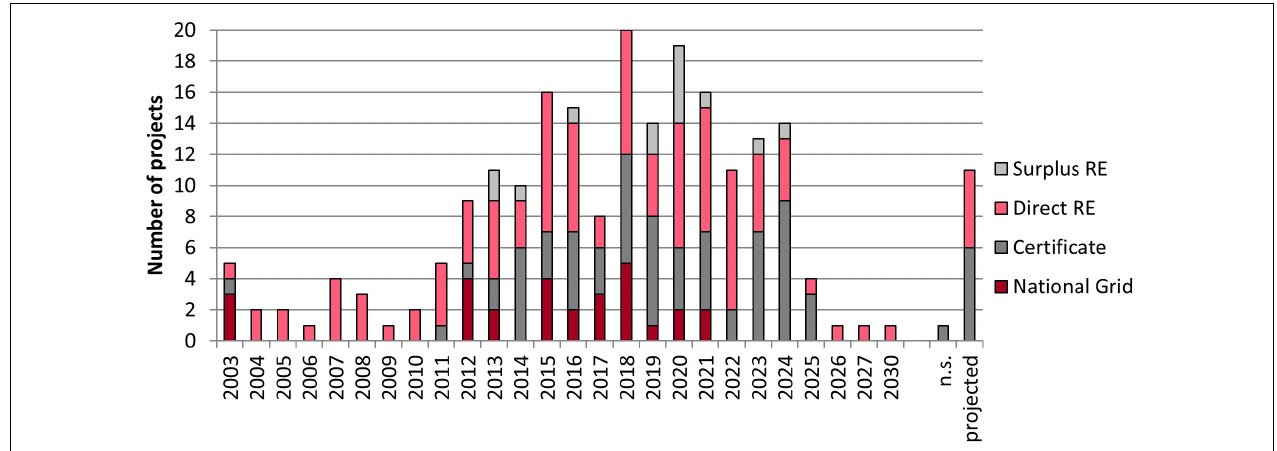
FIGURE 5 | Historical development of Power-to-X projects with regard to electricity supply. RE, renewable energy.